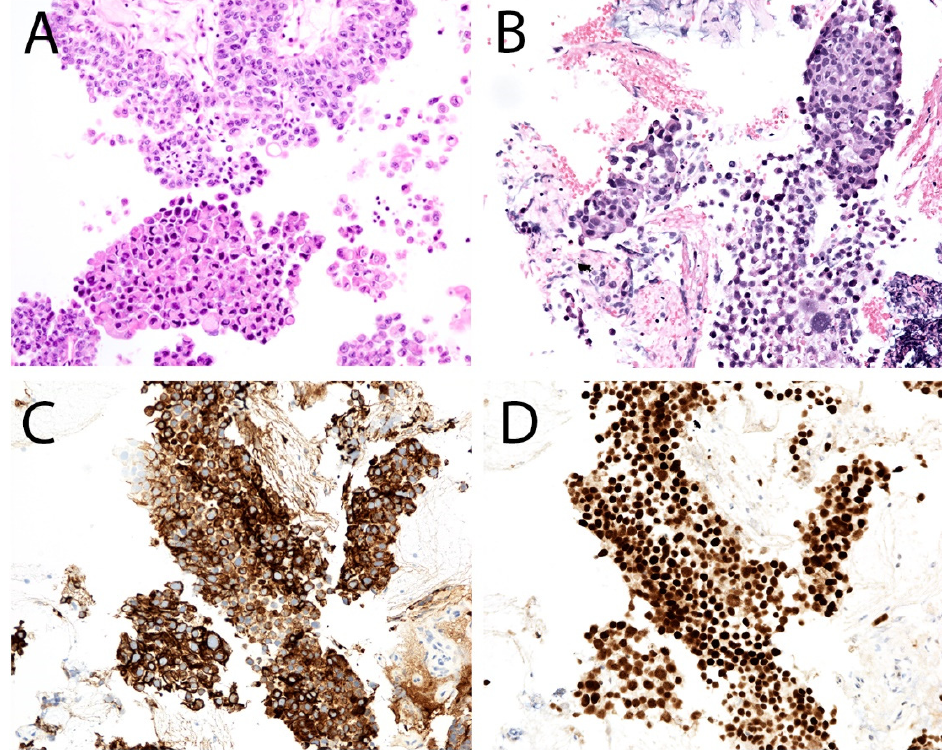
Figure 8. Two examples of high-grade urothelial carcinoma in cell block preparations ( A , B ). Example A demonstrate the papillary architecture of a high-grade urothelial carcinoma. For the second example, diffuse staining with CK20 ( C ) and p53 ( D ) supported the diagnosis, highlighting the utility of cell block preparations when used together with immunohistochemistry.